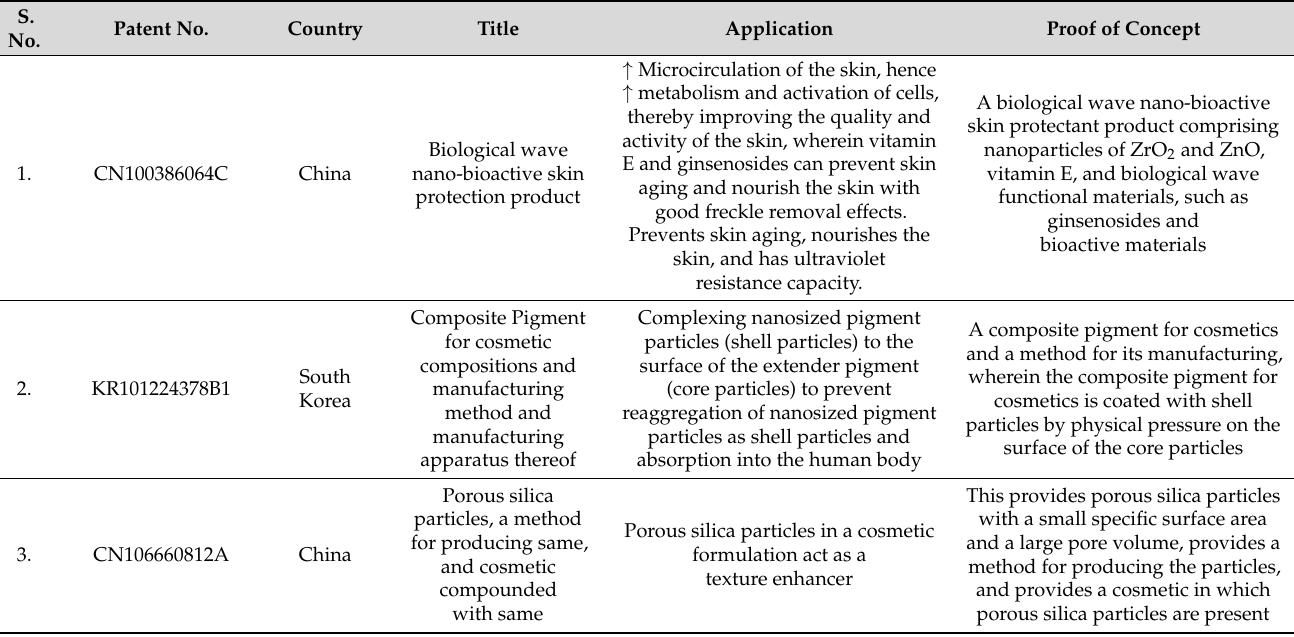
Table 3. List of patents related to